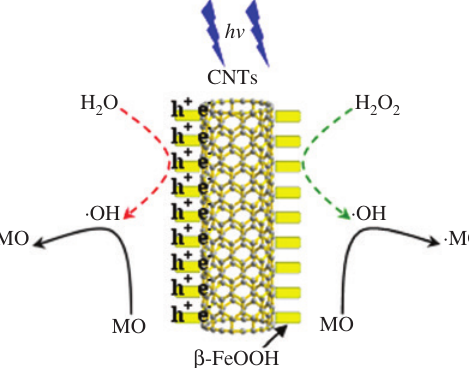
Figure 3: The photocatalytic schematic diagram of CNTs/ β FeOOH samples.